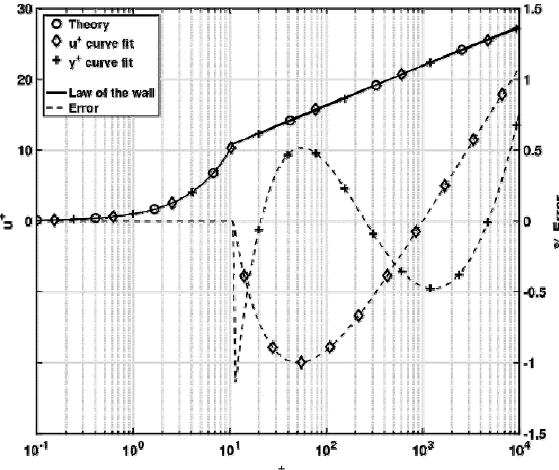
Figure A1. Comparison of the original and transformed wall functions. The solid line labeled f ( y t + ) corresponds to the wall function defined with respect to y t + given by Equation A4 and Equation A7. Dashed line labeled g ( r + ) corresponds to the wall function defined as a function of variable r + and given by Equation A4 and Equation A7. The viscous sublayer solution was extended to values y t + ≤ 10.8 for comparison purposes. The dashed lines indicate the percent error from the law of the